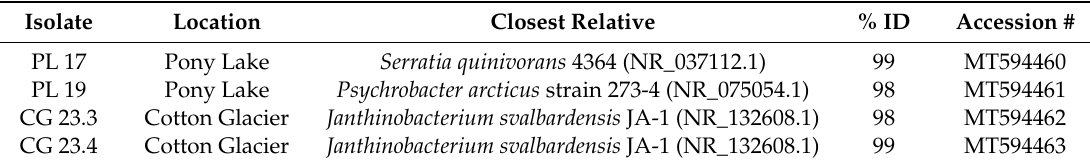
Table 1. Antarctic bacterial isolates and their closest relatives based on 16S rRNA gene sequence identity. Isolate